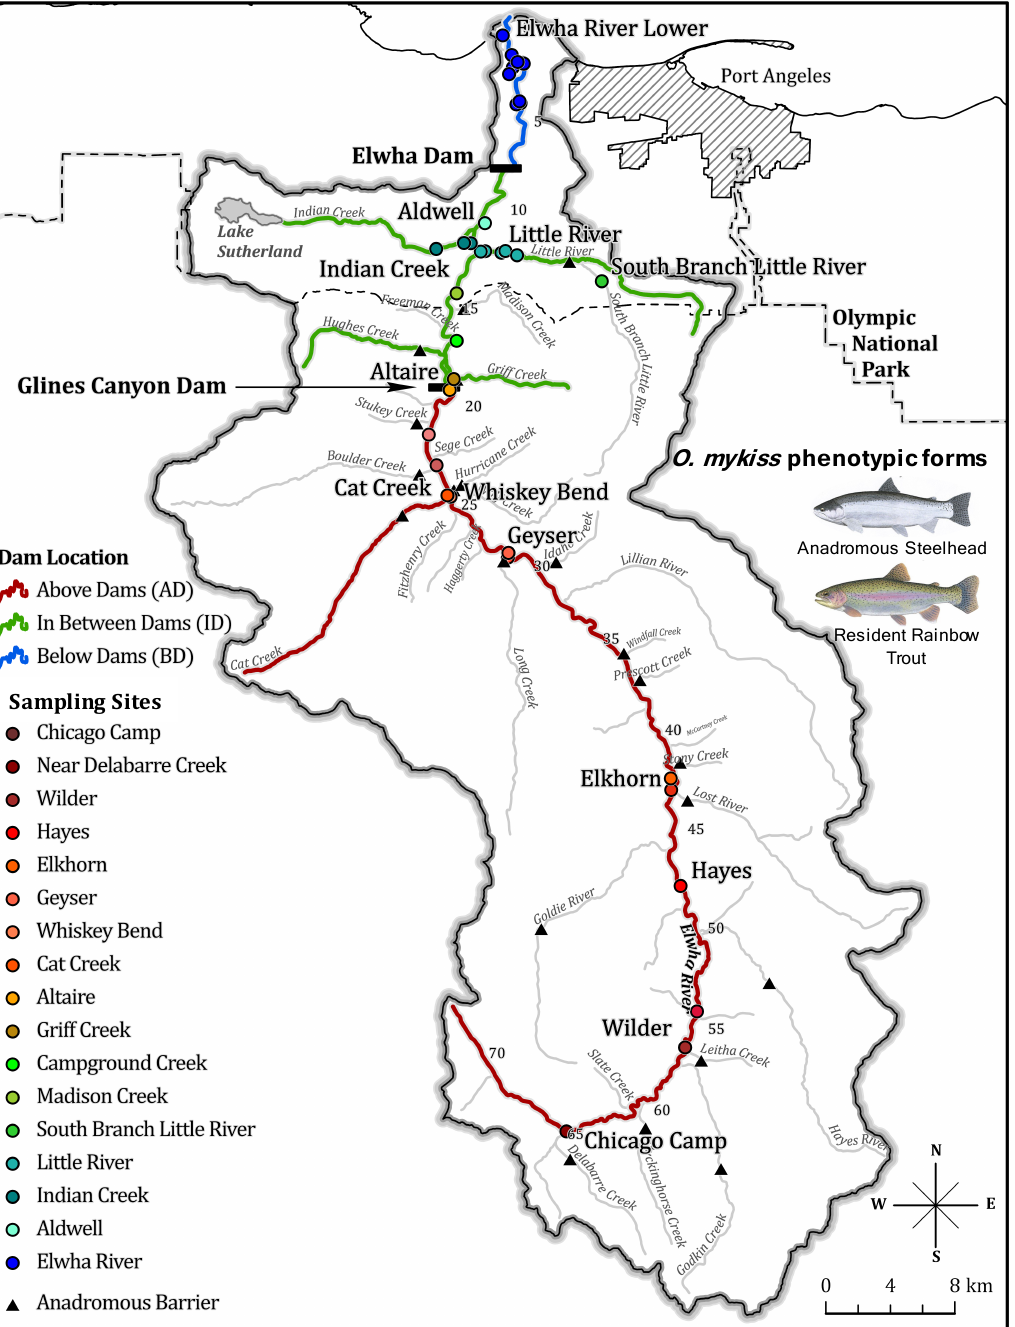
Figure 1. Map of all Oncorhynchus mykiss sampling sites across the Elwha River watershed on the Olympic Peninsula of Washington State. River segments are colored based off of relative dam location (population) and sampling locations are labelled and colored in a shade of the relative population color. Cartoons depict the two life history phenotypic forms of Oncorhynchus mykiss (art from graphics produced by Joseph Tomelleri) sampled in this